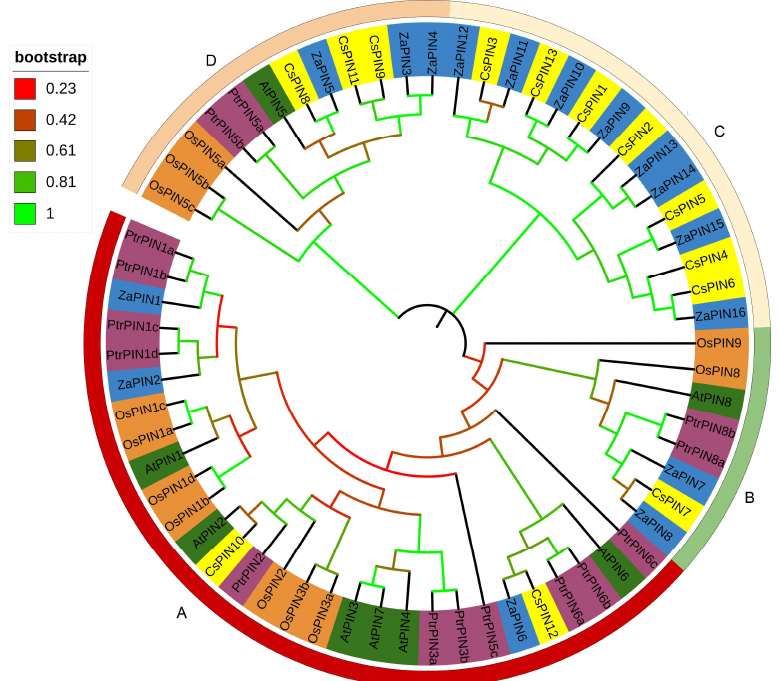
Figure 3. Phylogenetic analysis of PIN proteins among five plant species (conducted using MEGAX with the neighbor joining method). Za: Z. armatum ; At: A. thaliana ; Os: O. sativa ; Ptr: P. trichocarpa ; Cs: C. sinensis. A-D represent four phylogenetic groups.